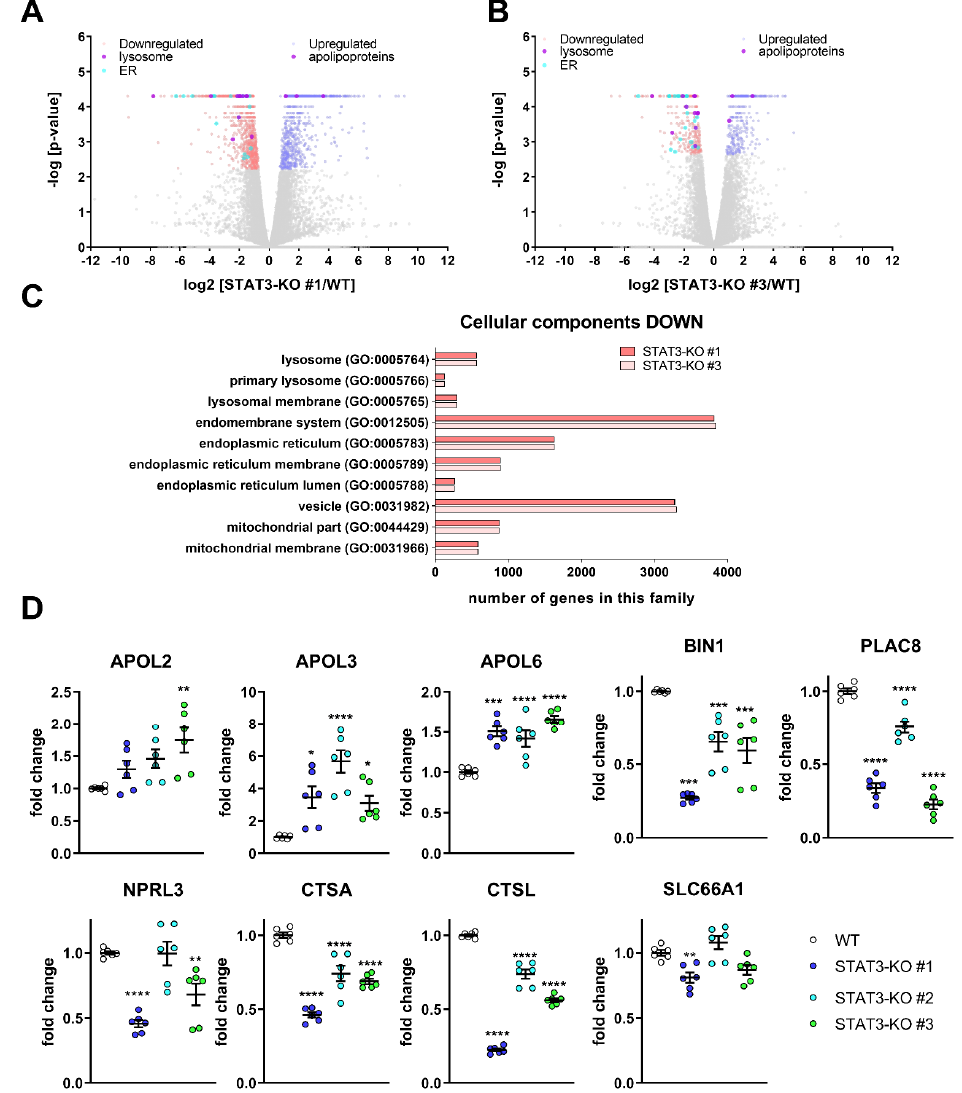
Figure 3. Transcriptomic analyses after STAT3 depletion in MZ-54-cells reveal changes in lysosomal genes and lipid metabolism and validation of selected target genes. ( A , B ) Volcano Plots of ( A ) STAT3-KO#1 vs. WT and ( B ) STAT3-KO#3 vs. WT displaying significantly decreased (red) and increased (blue) transcripts. Transcripts related to the lysosome (violet, left side) and ER (cyan, left side) as well as apolipoproteins (violet, right side) are displayed among the significantly regulated transcripts. ( C ) Bar graphs of selected GO Cellular Component processes after performing an enrichment analysis using PANTHER (Version 14.1, [56]). ( D ) Point Plots of Taqman-based gene expression analyses of the selected high-ranking candidates APOL2, APOL3, APOL6, BIN1, PLAC8, NPRL3, CTSA, CTSL and PQLC2 from the whole transcriptome analyses of MZ-54 WT cells and STAT3-KO cells. Summary of two experiments performed in triplicates. * p < 0.05; ** p < 0.01; *** p < 0.001; **** p > 0.0001; One-Way ANOVA with Dunnetts multiple comparison test (GraphPad Prism